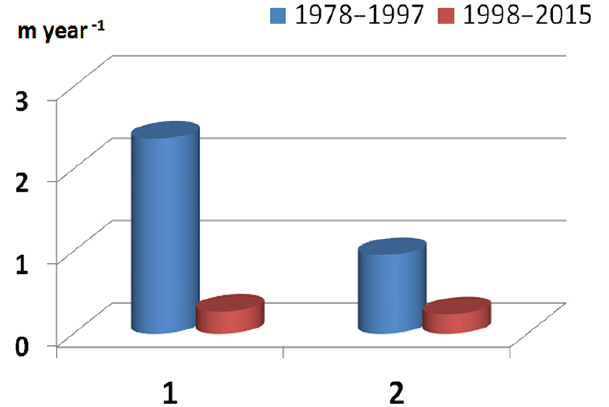
Figure 6. The mean gully head retreat for gully catchments with “warm” and “cold” aspects for the periods 1978–1997 and 1998– 2015 (Legend: 1 – gully catchment with “cold” aspects (N, NE, NW and E); 2 – gully catchment with “warm” aspects (S, SW, SE,